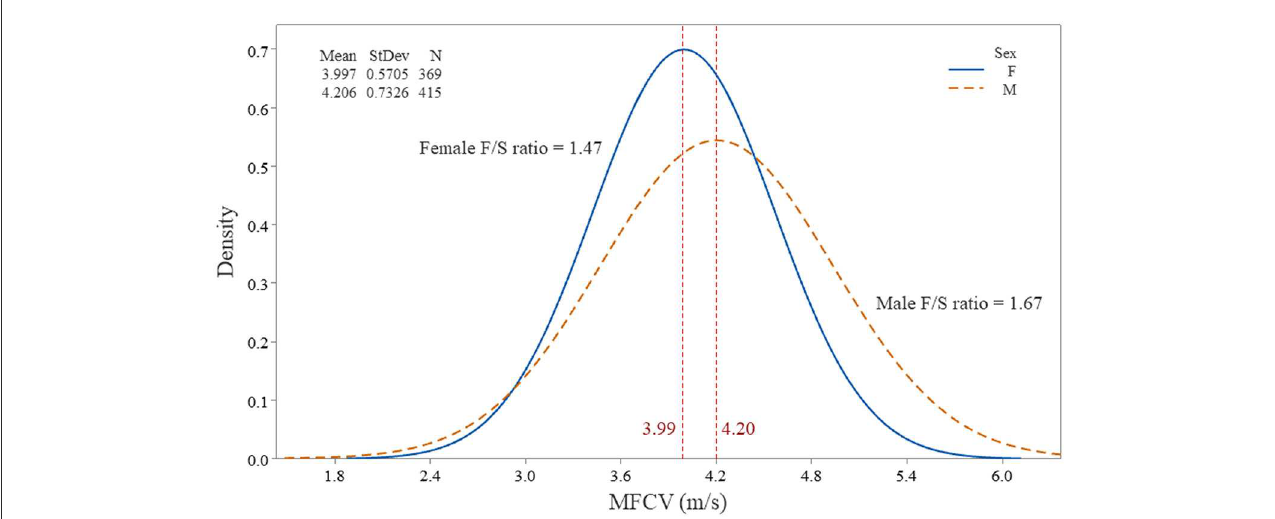
FIGURE6 Histogram of the individual muscle fiber action potentials (784) from 36 subjects and its distribution, according to the muscle fiber conduction velocity (MFCV). Note the female and male subjects on separate curves. The fast-to-slow MFCV ratio (F/S ratio) was higher in male subjects, indicating a more significant muscle fiber diameter variation.